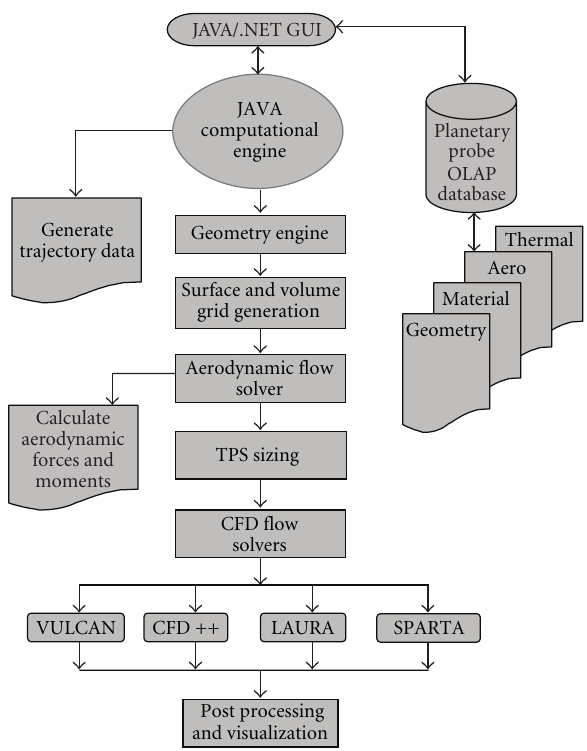
Figure 1: Sparta framework software